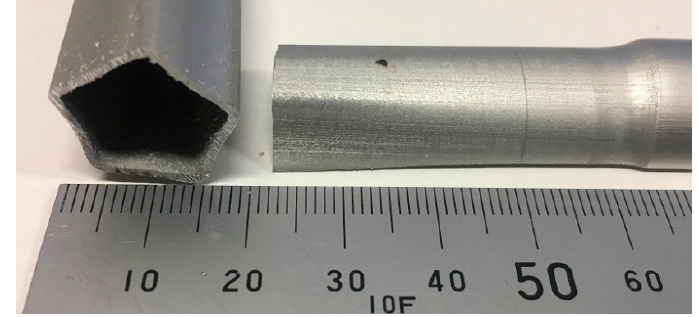
Figure 5. Pentagonal deformation.